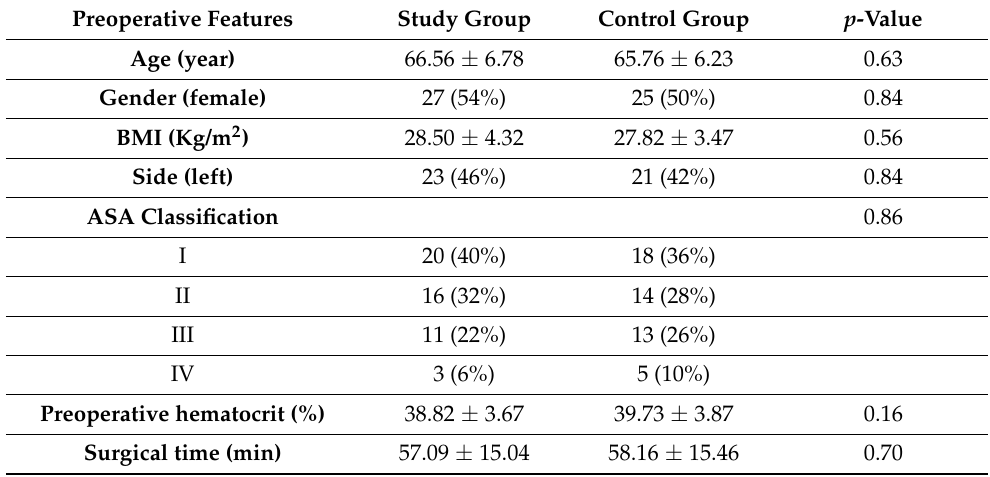
Table 1. Main data of the study. Preoperative